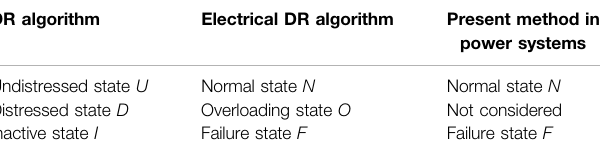
TABLE 1 | States between the DR algorithm and electrical DR algorithm and the present method in power